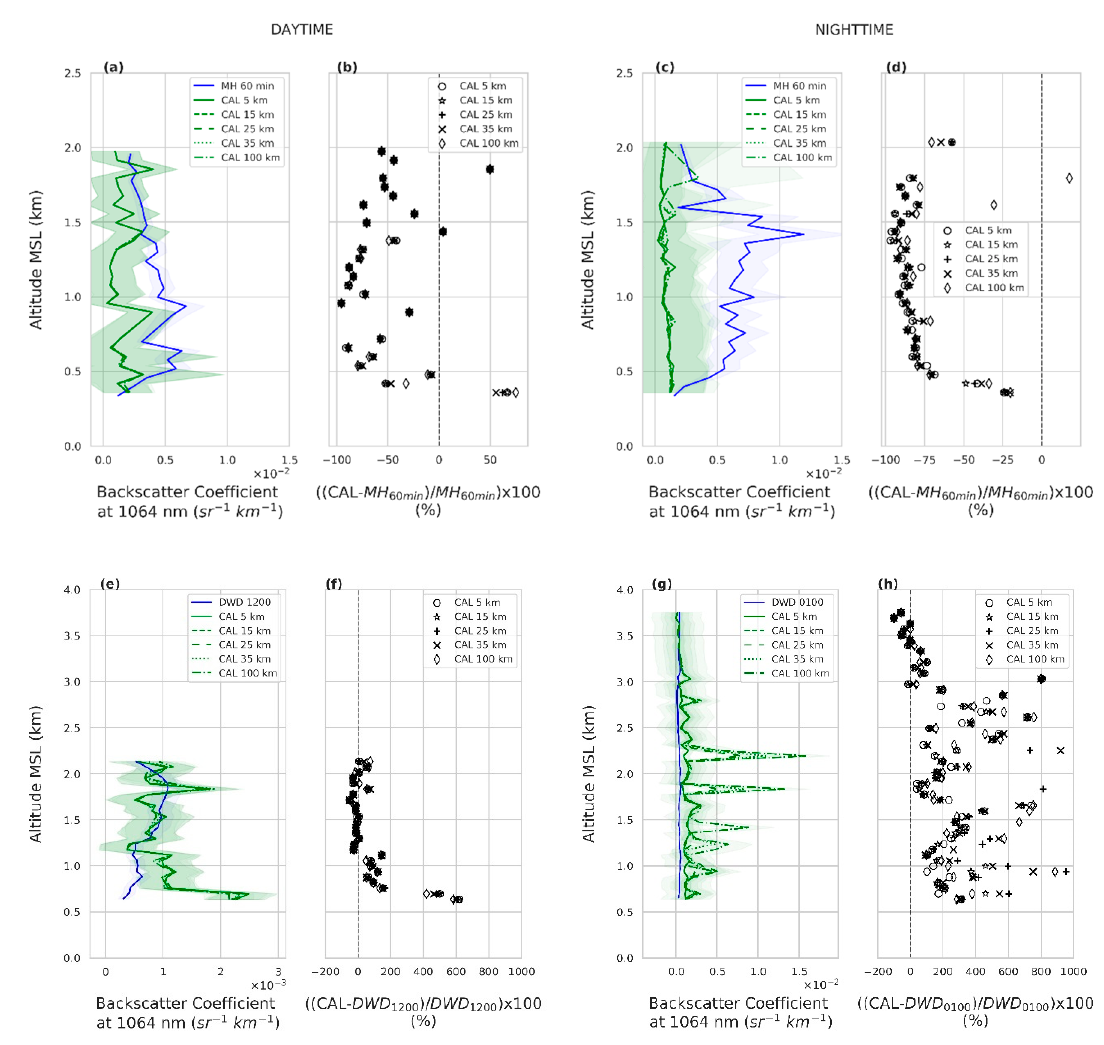
Figure 9. Mean backscatter coefficient at 1064 nm profiles measured by CALIOP (green lines) and ceilometers (blue lines) for both daytime and nighttime overpasses with their respective standard deviations (shaded area) and the corresponding mean percentage difference between the measurements for: ( a , b ) Mace Head 6 daytime cases; ( c , d ) Mace Head 9 nighttime cases and ( e , f ) Harzgerode 4 daytime cases and ( g , h ) Harzgerode 24 nighttime cases.